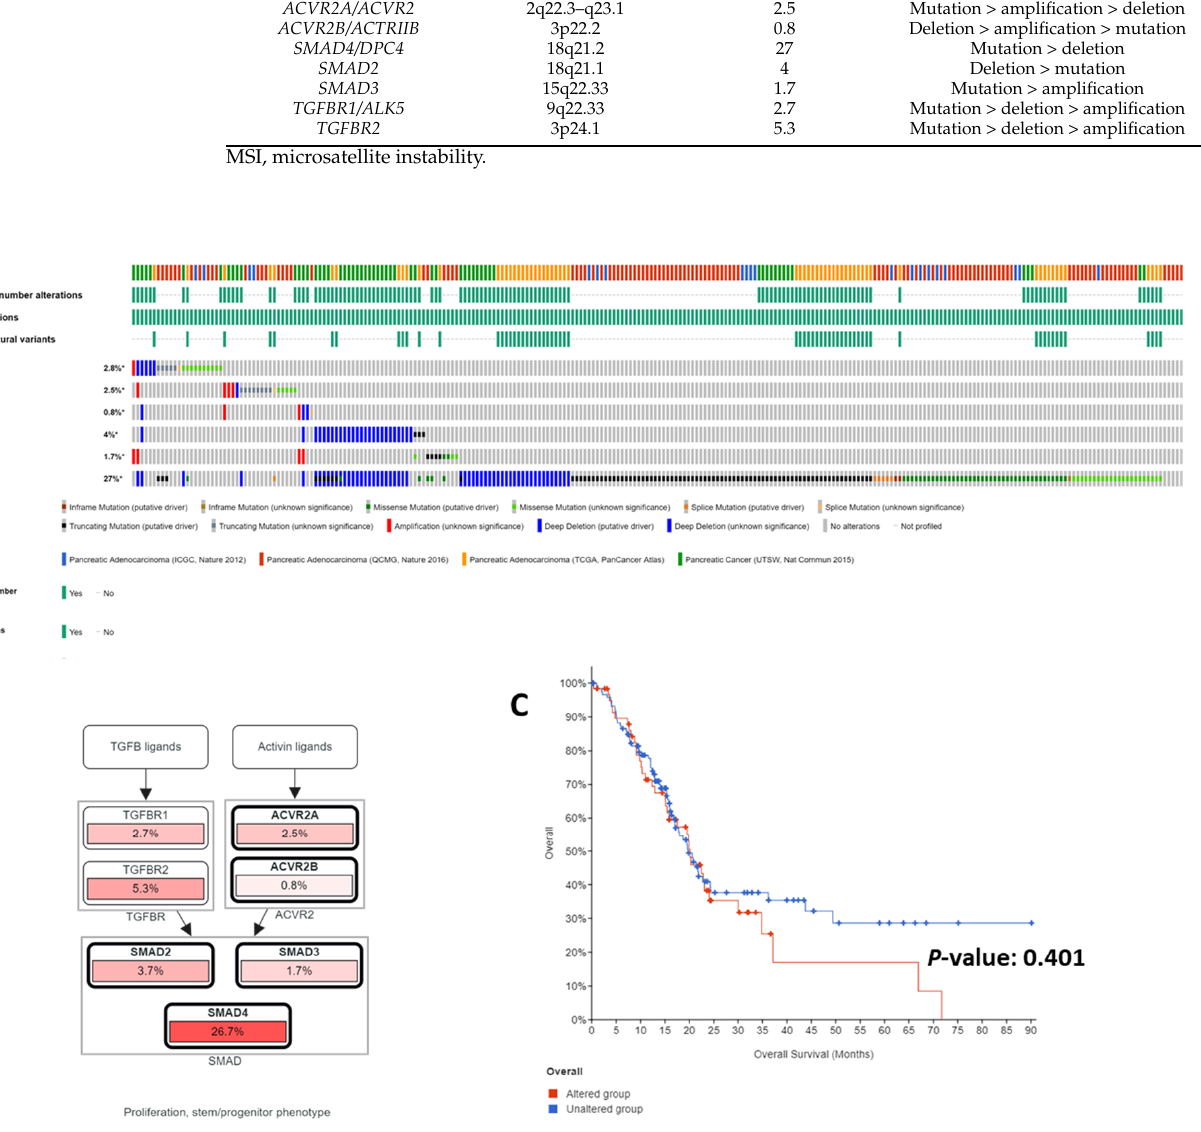
Figure 2. Genomic alterations in the activin/TGF β signaling pathway. Analyses of the Cancer Genome Atlas (TCGA) databases using the cBioPortal ( A – C ), which revealed mostly inactivating mutations and deletions in the activin/TGF β signaling axes ( A ). Collectively, the activin/TGF β signaling pathway is one of the most frequently disrupted core signaling axes in pancreatic cancer ( B ). No significant correlation exists between patient survival and genomic alterations of the activin/TGF β signaling axes, perhaps due to the dual roles of the activin/TGF β signaling pathway in pancreatic cancer ( C ).